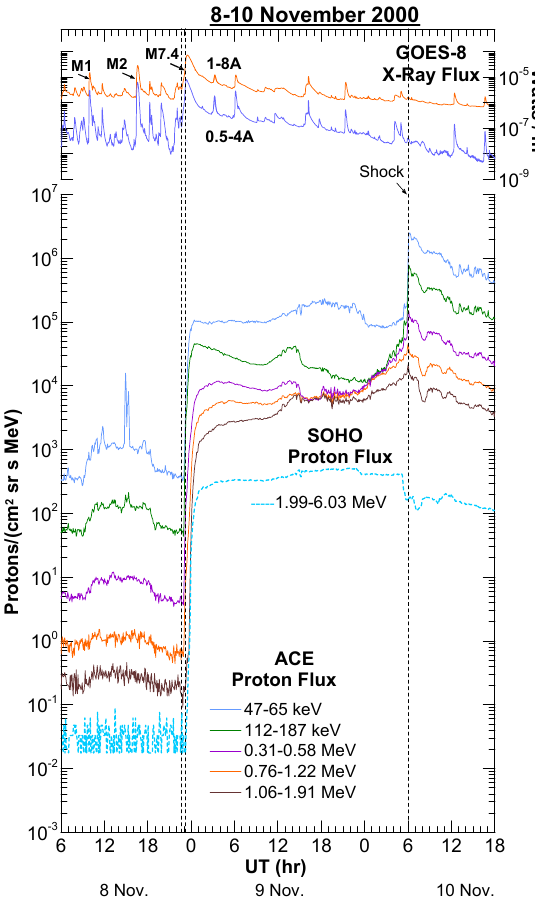
Fig. 5. Upper panel shows X-ray flux at two wavelengths 0.5–4 ˚A and 1–8 ˚A. Proton flux characteristics in various energy lev- els of 47–65keV, 112–187keV, 0.31–0.58MeV, 0.76–1.22MeV and 1.06–1.91MeV (ACE) and 1.99–6.03MeV (SOHO) for 8–10 November 2000 are shown in the lower panel.